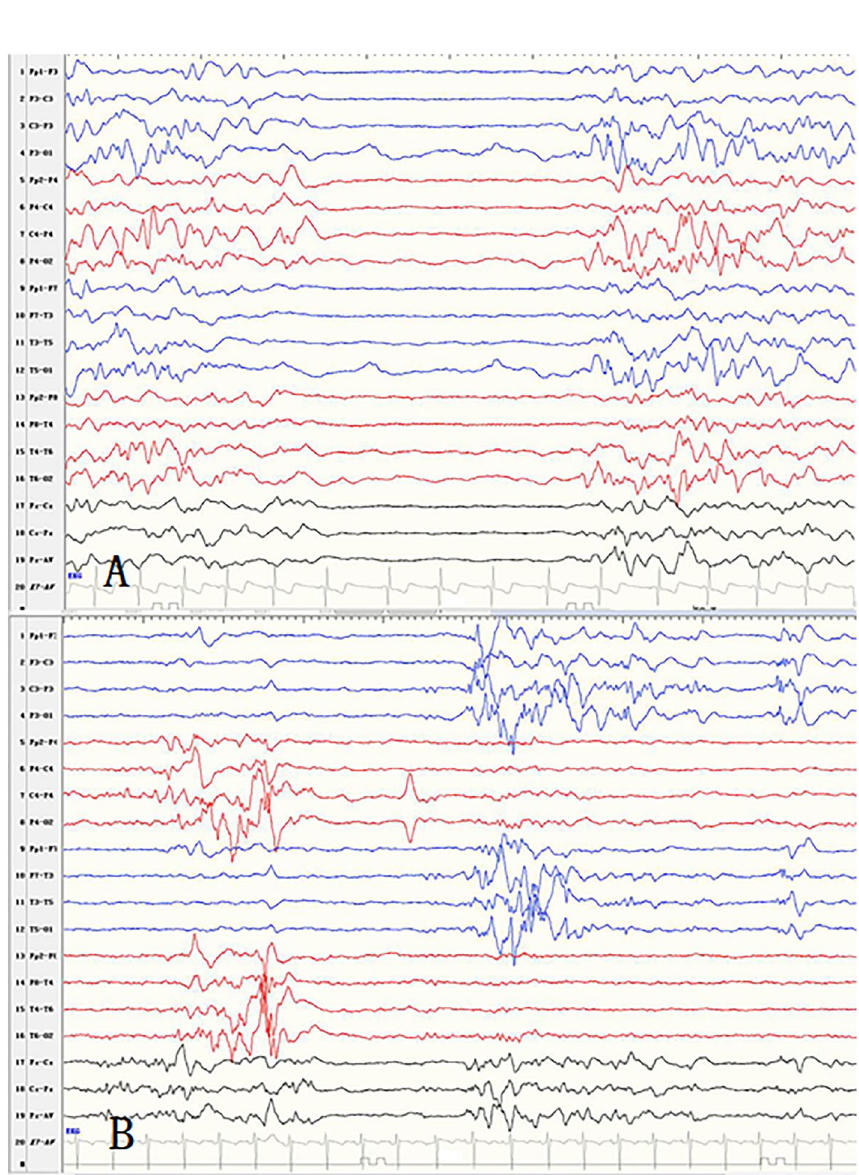
Figure 2. ( A ) The synchronous and symmetric burst suppression pattern in a patient with genetic disorder. ( B ) The asynchronous but symmetric burst suppression pattern in a patient with genetic